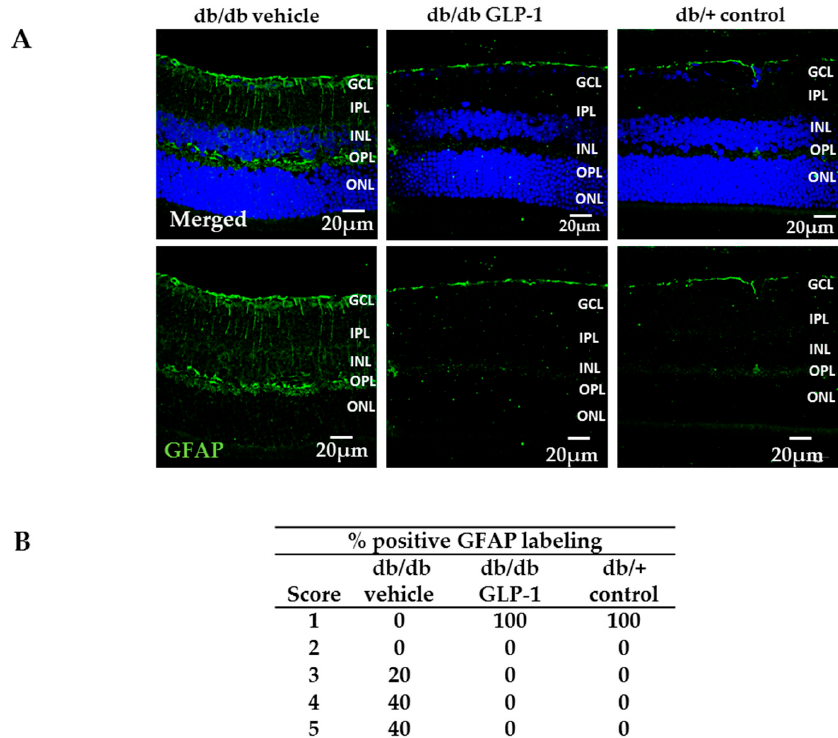
Figure 2. Glial activation. ( A ) Comparison of glial fibrillary acidic protein (GFAP) immunoreactivity (green) among representative samples from diabetic mice treated with vehicle or glucagon-like peptide-1 (GLP-1) eye-drops and from a non-diabetic mouse. Scale bars, 20 µ m; ( B ) Quantification of glial activation based on the extent of GFAP staining. n = 4 mice per group (five retinal sections per mouse).